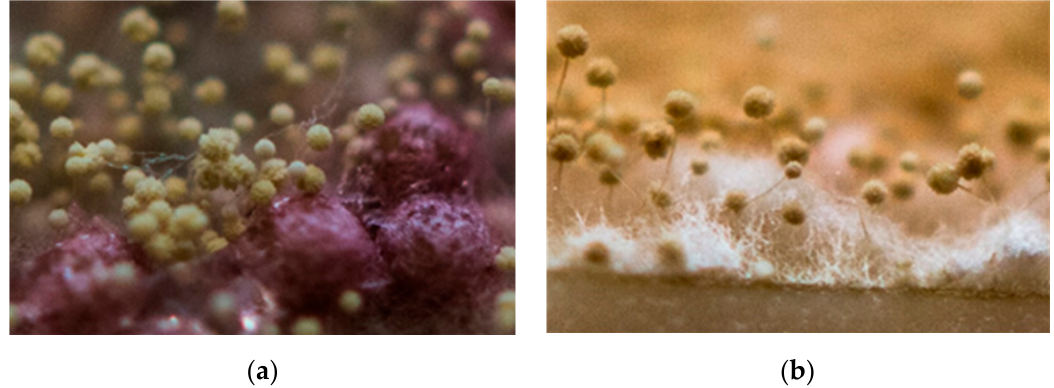
Figure 1. Images of three-day growth of Aspergillus melleus : ( a ) in the dark and ( b ) under irradiation in the presence of commercial titania photocatalyst P25 (after homogenization); adapted with permission (after formatting) from [79]. Copyright (2015) Elsevier.